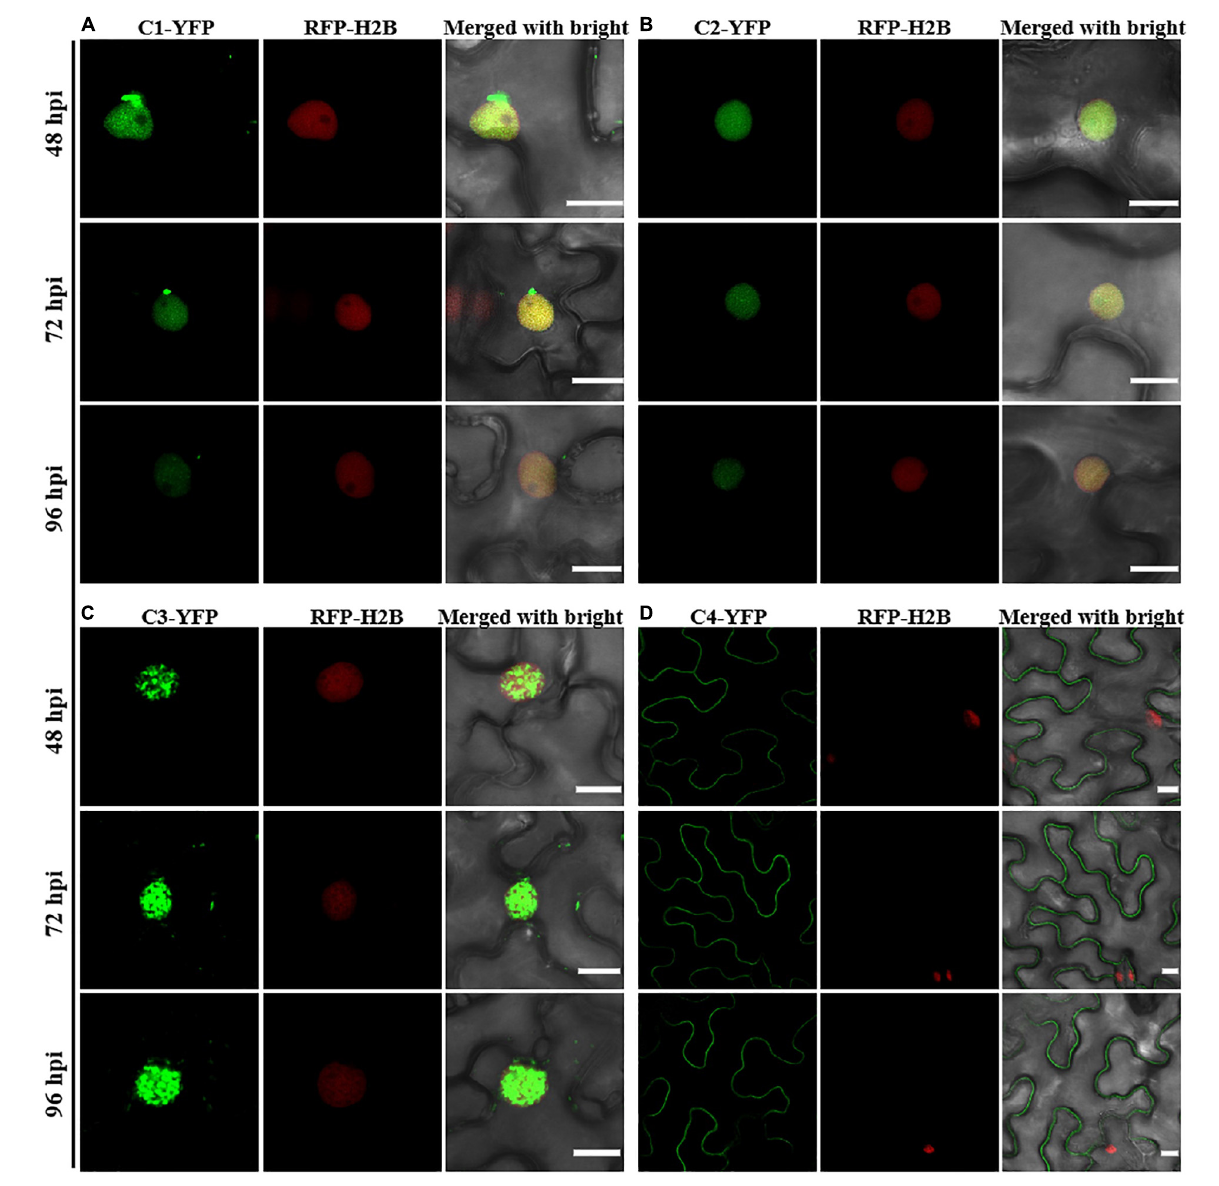
FIGURE 1 | Confocal images of TYLCCNV C1, C2, C3, or C4 proteins fused with YFP. RFP-H2B transgenic Nicotiana benthamiana leaves were infiltrated with Agrobacterium cultures to express C1-YFP (A) , C2-YFP (B) , C3-YFP (C) , or C4-YFP (D) . Confocal images were taken at 48, 72, and 96 h post infiltration (hpi). YFP signal is shown in green. Nuclei of tobacco leaf epidermal cells are marked by RFP-H2B (red). This experiment was repeated three times independently, and more than 20 cells per sample were observed each time; representative results are shown. Scale bar: 10 µ